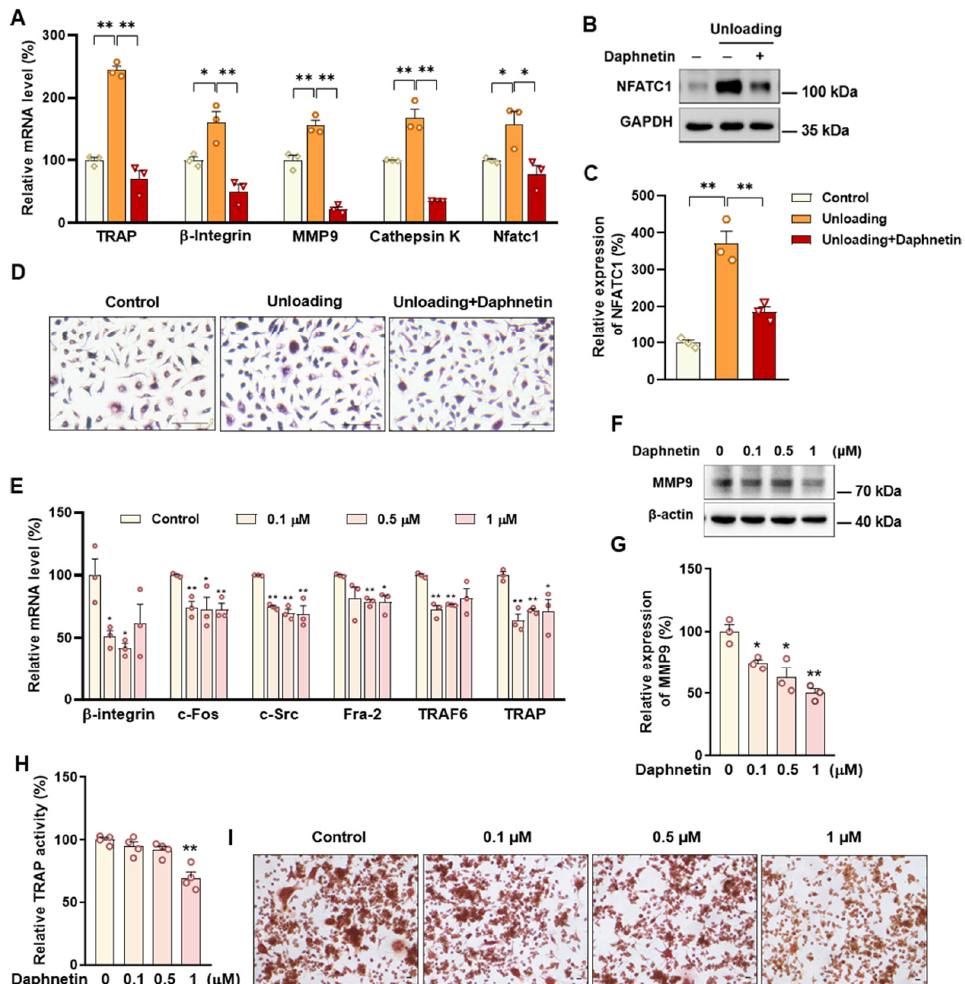
Figure 6. The effects of daphnetin on bone resorption in hindlimb unloading mice and osteoclast differentiation of RAW264.7 cells. Bone marrow monocyte-derived osteoclasts were also isolated from mice and induced to differentiate for 6 days. ( A ) The mRNA levels of bone resorption-related marker genes were determined by qRT-PCR. ( B , C ) The expression of NFATC1 was determined by Western blot ( B : Western blot image; C : statistical analysis). ( D ) TRAP staining was performed and observed with microscope. RAW264.7 cells were treated with indicated concentrations of daphnetin, and induced differentiation in vitro. After differentiation for 3 days, the mRNA levels of bone resorption marker genes were determined by qRT-PCR ( E ), the expression of MMP9 was determined by Western blot (( F ) Western blot image; ( G ) statistical analysis). ( H ) TRAP activity in cell homogenates was determined. ( I ) TRAP staining was performed and observed with microscope after differentiation for 4 days. Data are mean ±S.E.M. ( n ≥ 3); * p < 0.05; ** p < 0.01 between the connected groups or versus control.